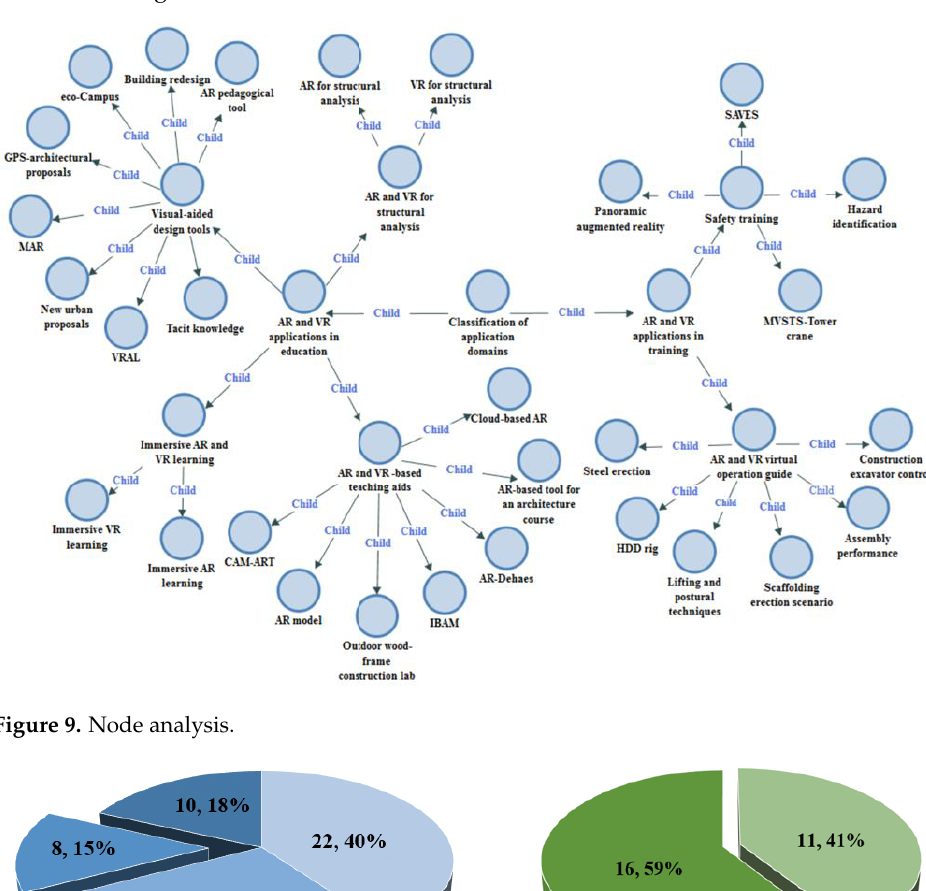
Figure 9. Node analysis.